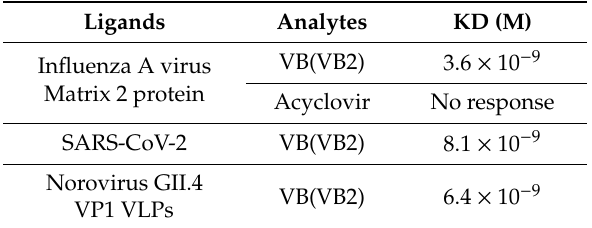
Table 2. Binding a ffi nity of VB to virus compartments by